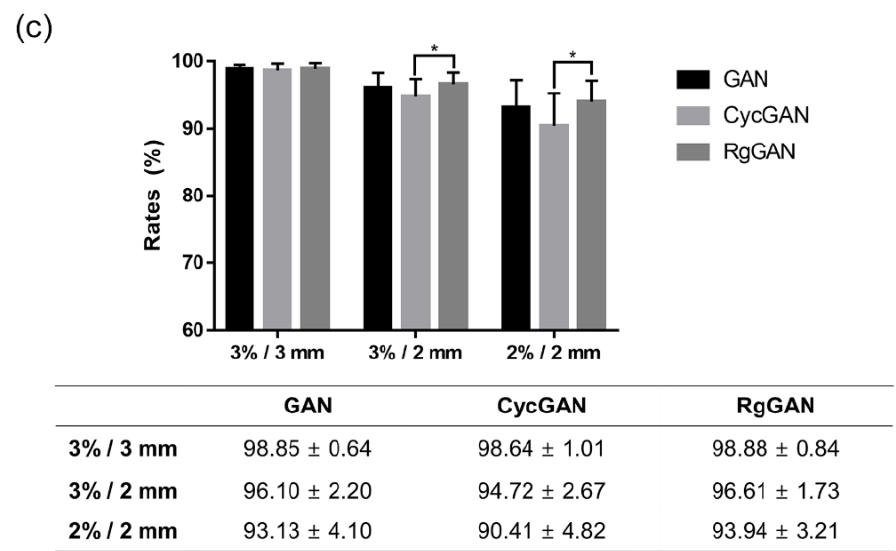
Figure 5. ( a ) Example for the comparison of dosimetric distributions on original and synthetic computed tomography according to the deep learning techniques. Dosimetries of axial, coronal, and sagittal views for volumetric modulated arc therapy (VMAT) on original computed tomography (CT), and synthetic CTs (sCT) based on generative adversarial network (GAN), cyclo-consistent GAN (CycGAN), and Reference-guided CycGAN (RgGAN). The dosimetric distributions are represented on axial (right), coronal (middle), and sagittal (right) slices of original CT, and sCTs generated from GAN, CycGAN, RgGAN from the uppermost row to lowermost row ( a ). ( b ) Difference of dosimetric parameters in planning target volume on sCTs according to the deep learning techniques comparing with original plan for VMAT. ( c ) Comparisons of gamma-pass rates among the sCTs according to the deep learning techniques for VMAT. Abbreviations: PTV, planning target volume; VMAT, volumetric modulated arc therapy; PBT, proton beam therapy; GAN, generative adversarial network; CycGAN, cyclo-consistent generative adversarial network; RgGAN, Reference-guided cyclo-consistent generative adversarial network. * 0.01 < p < 0.05, ** 0.001 < p < 0.01, *** p <